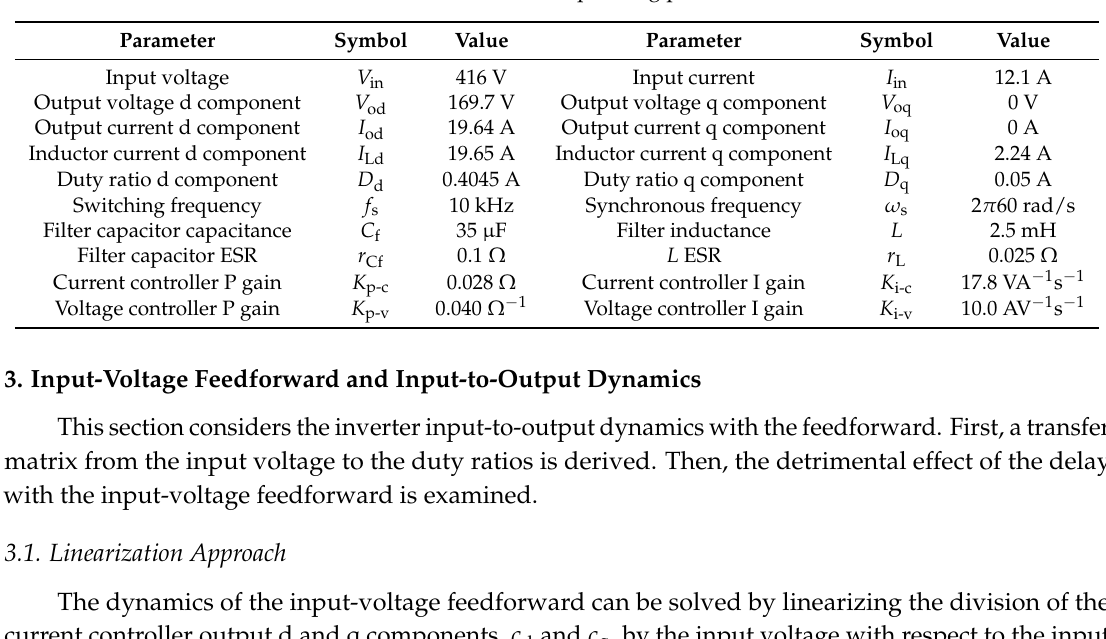
Figure 2. ( a ) Control block diagram of the inverter system. ( b ) Circuit diagram of the input and the output dynamics with the feedforward. Table 1. Parameters and operating point